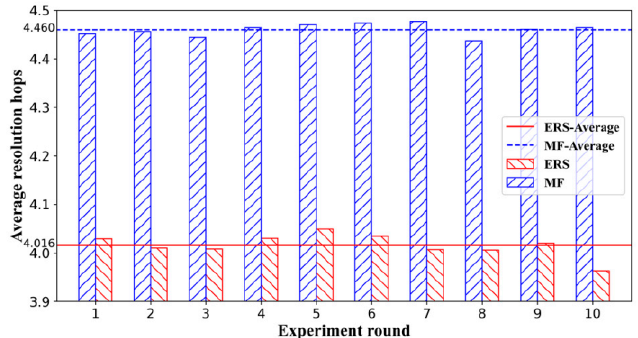
Figure 11. Average resolution hops for each content